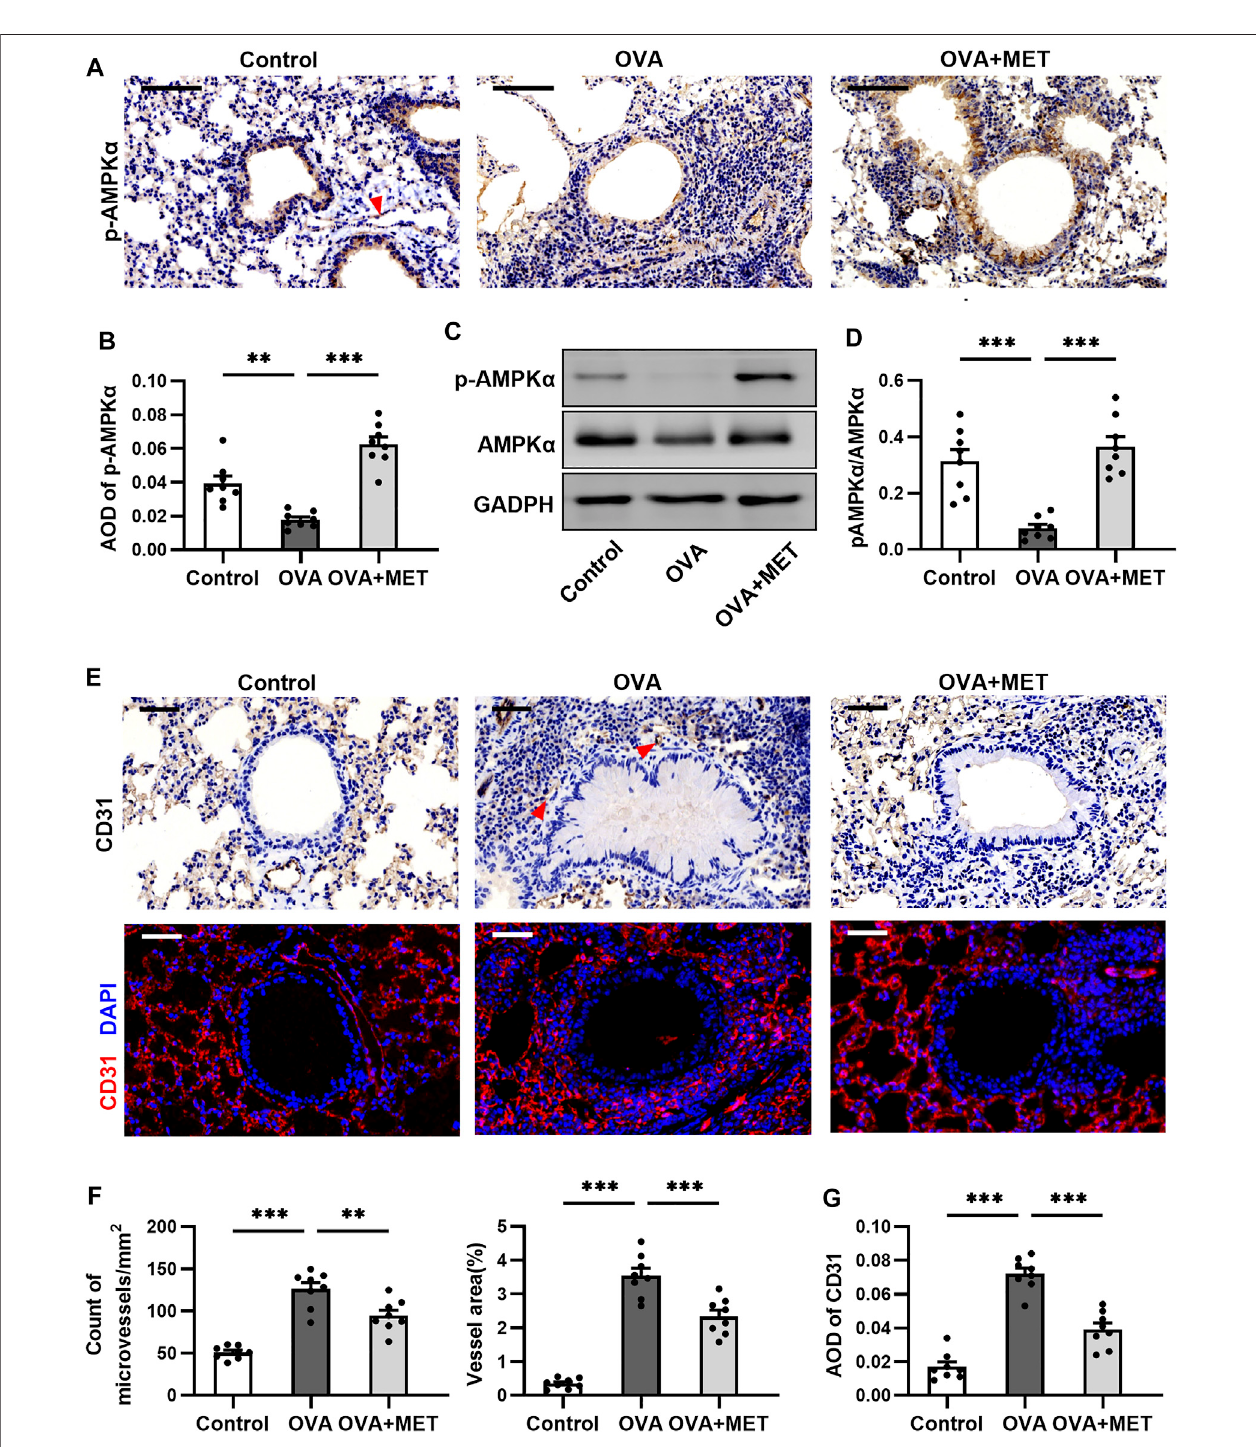
FIGURE6| MetforminrestoresAMPKactivityandimpairsangiogenesisinthesub-epitheliuminlungsofasthmaticmice. (A,B) .Representativeimagesandblinded quantitative analyses of p -AMPK immunoreactivity in lung sections from each group. The red arrow points to the vascular endothelium stained with p-AMPK α . (C,D) . Representative Western blots and densitometric analyses of p -AMPK and AMPK in lung tissues from each group. (E) . Representative images of microvessels with anti- CD31 immunohistochemical and immuno fl uorescent staining of lung sections. Red arrows point to microvessels stained with CD31. (F) . Blinded quantitative analysis of the number and area of microvessels positive for CD31 immunostaining in the sub-epithelial region. (G) . Blinded quantitative analysis of fl uorescence intensities for CD31 staining in the sub-epithelial region. Data were presented as msean ± SEM ( n (cid:1) 8 animals, 20 bronchioles/3 sections of an animal, each bronchiole with 100 – 200 μ m of internal diameter). All images are at × 400 magni fi cation. Scale bar (cid:1) 50 μ m * p < 0.05, ** p < 0.01, *** p < 0.001.